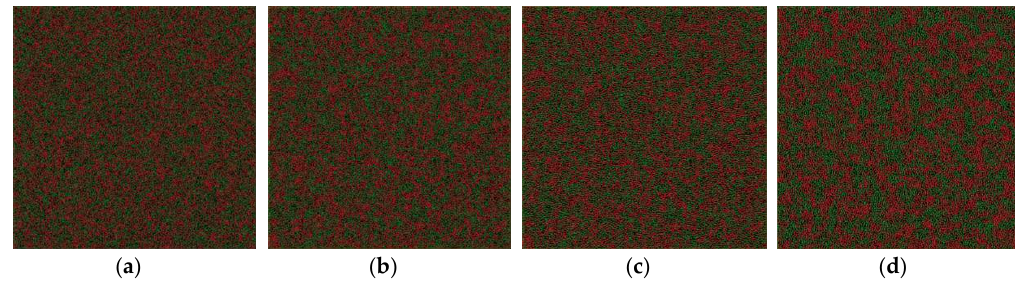
Figure 4. Atom snapshot of Fe 50 Cu 50 at different temperatures at the cooling rate of 6.4 × 10 12 K/s. ( a – d ) correspond to the atomic configuration at temperature of 2800 K, 2200 K, 1900 K, 800 K, respectively.